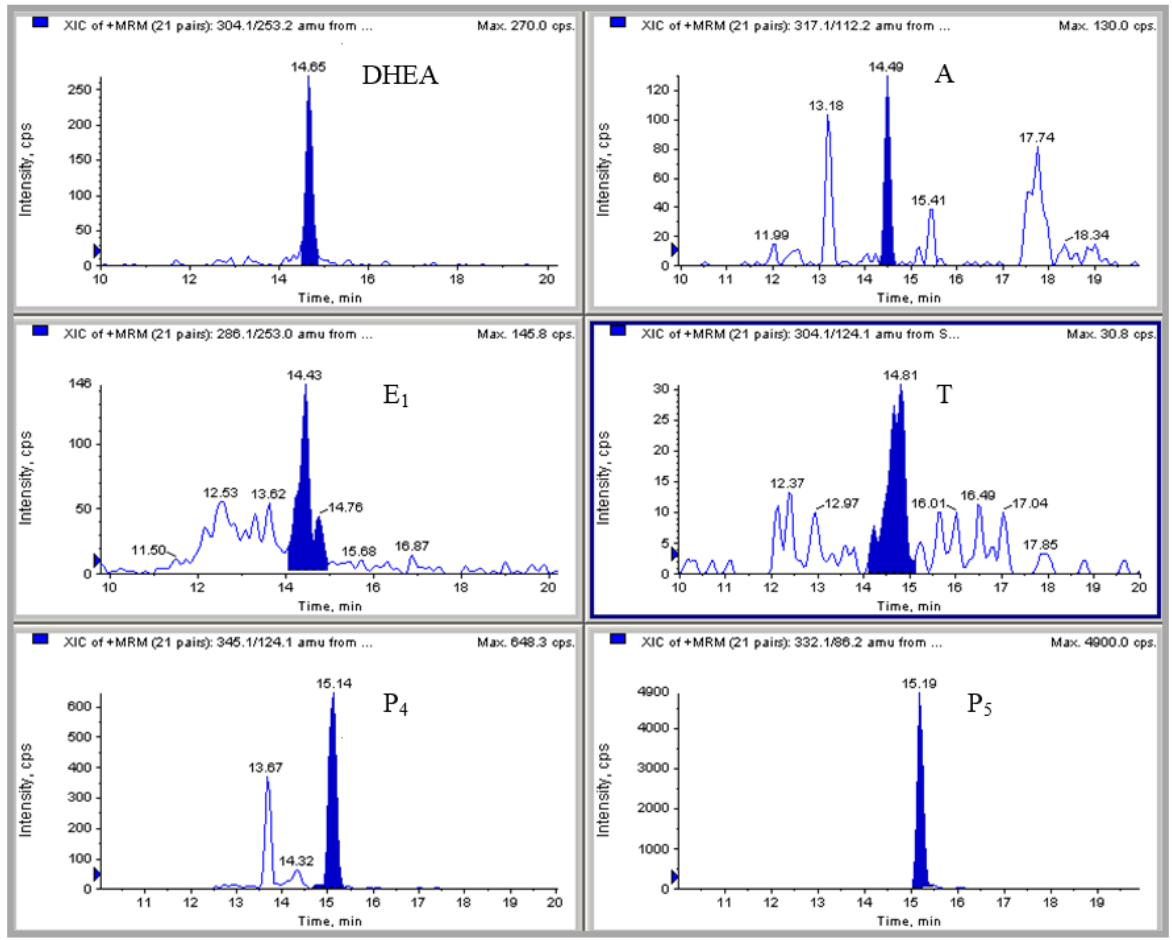
Figure 3. LC-MS/MS chromatogram of a first-stage infant formula, showing the presence of all the assayed hormones: pregnenolone (P 5 ), progesterone (P 4 ), estrone (E 1 ), dehydroepiandrosterone (DHEA), testosterone (T), and androstenedione